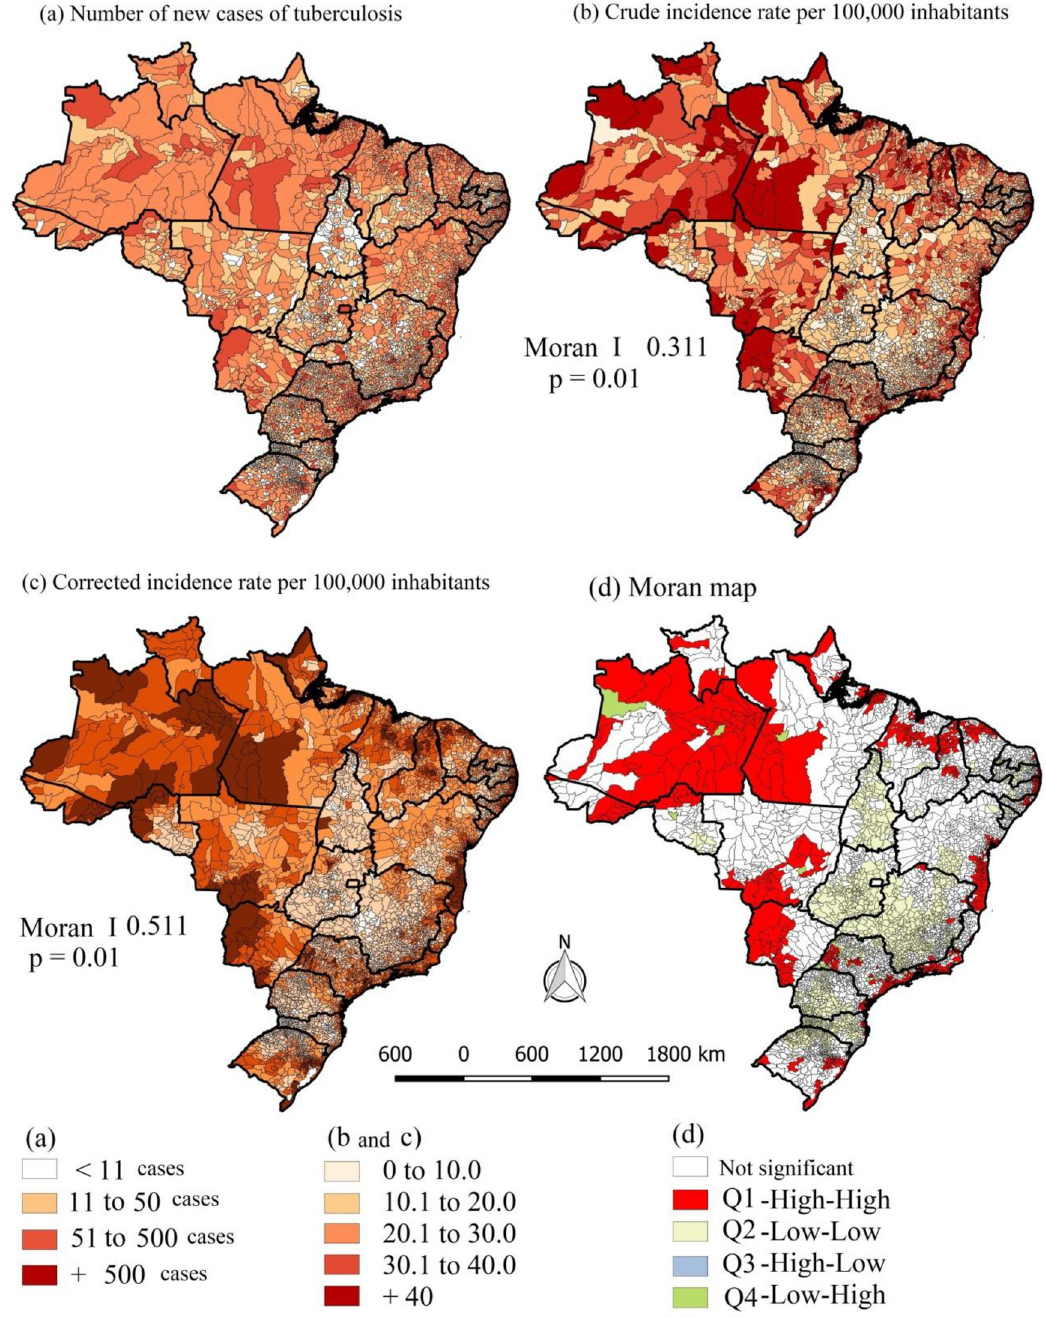
Fig 3. Spatial distribution of incidence rates of tuberculosis in Brazil, crude and smoothed by the local empirical Bayesian model, and Moran Map, 2001–2017. Map base layers were obtained from <